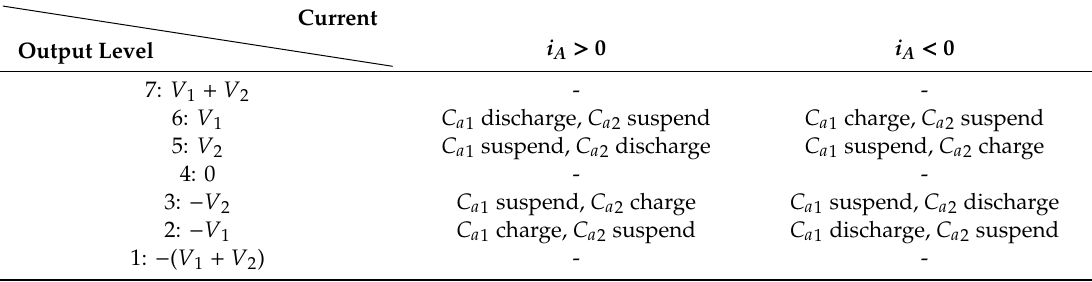
Table 3. State determination of C a 1 , C a 2 charge and discharge.